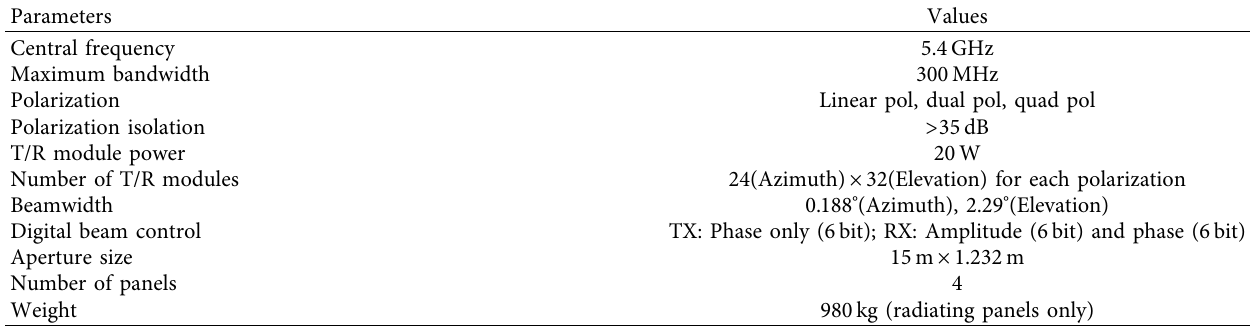
Table 1: SAR antenna parameters of